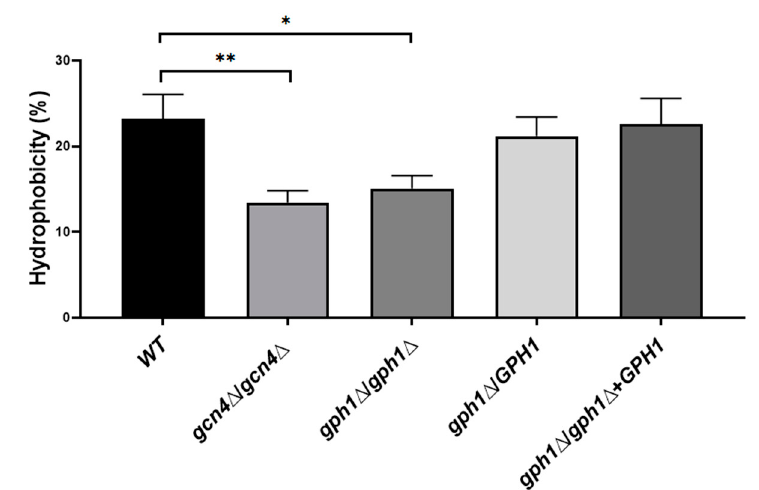
Figure 4. GPH1 has a role in positively regulating cell surface hydrophobicity in C. albicans . The hydrophobicity was measured according to a microbial adhesion to hydrocarbons (MATH) test, as described in the Materials and Methods. All assays are representative of at least three independent experiments performed in triplicate. The original cells read as an absorbance value: A0; the cells left after subjecting to n-hexadecane read as an absorbance value: A1; the hydrophobicity (%) = [1 − (A1/A0)] × 100. The GCN4 null mutant gcn4 Δ / gcn4 Δ , known to reduce biofilm formation, was included in the assay. Statistical analyses were performed by one-way ANOVA, with * p < 0.05 and ** p < 0.01 as indicated.